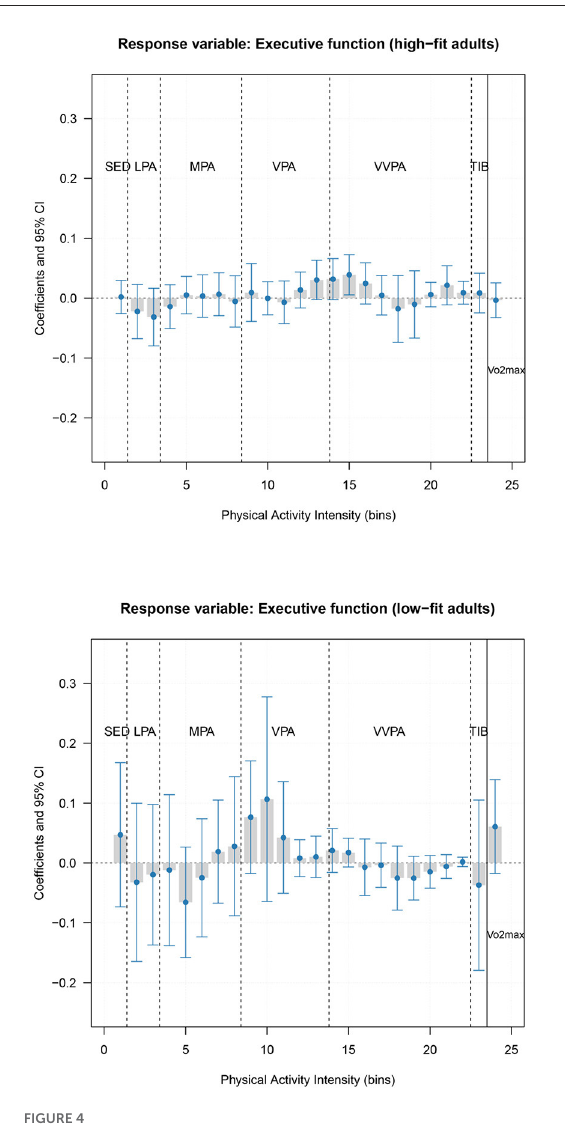
FIGURE3 Association of physical activity intensity variable (bin) and cardiorespiratory fitness with the executive function composite score. A positive bar indicates more time spent at that intensity is associated with higher executive function, while a negative bar indicates more time spent at that activity is associated with lower executive function. The last bar marked with Vo2max reflects the association between cardiorespiratory fitness and executive function. Model 1 is unadjusted model, and Model 2 was additionally adjusted for the influence of age, sex, and education level. SED, Sedentary; LPA, Light physical activity; MPA, Moderate